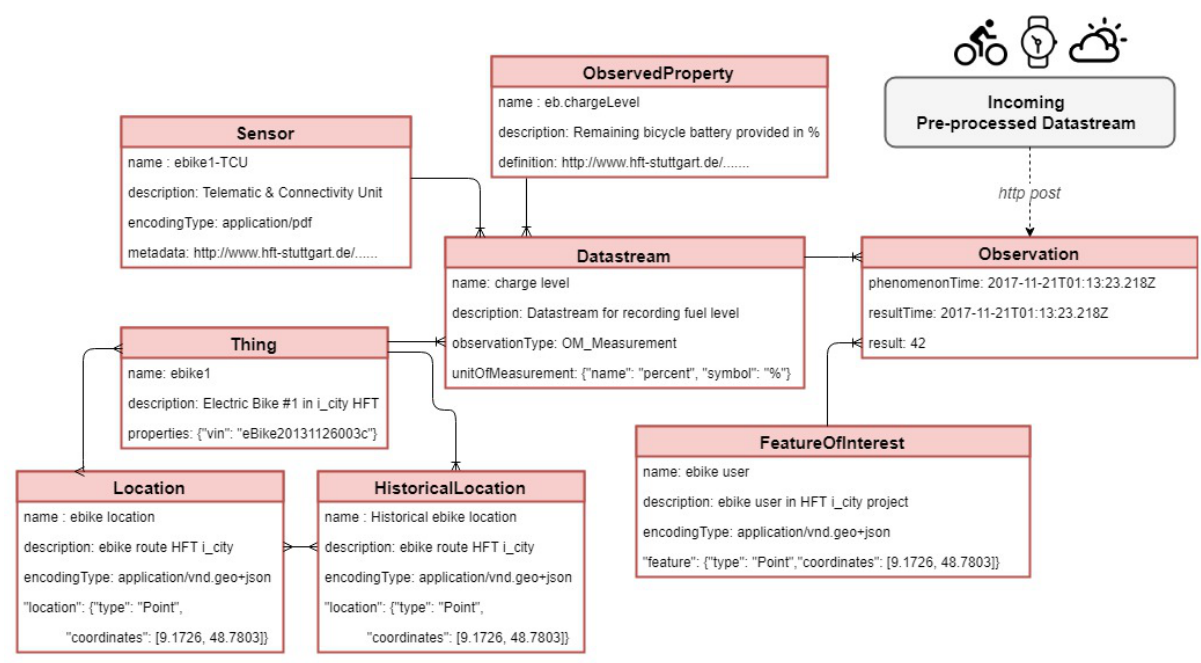
Figure 4: E-bike information structure based on SensorThings API standard